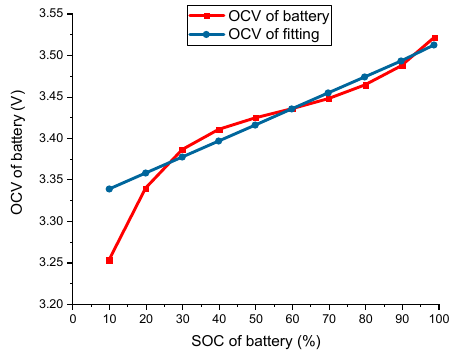
Figure 4. The relationship between V bat and SOC.